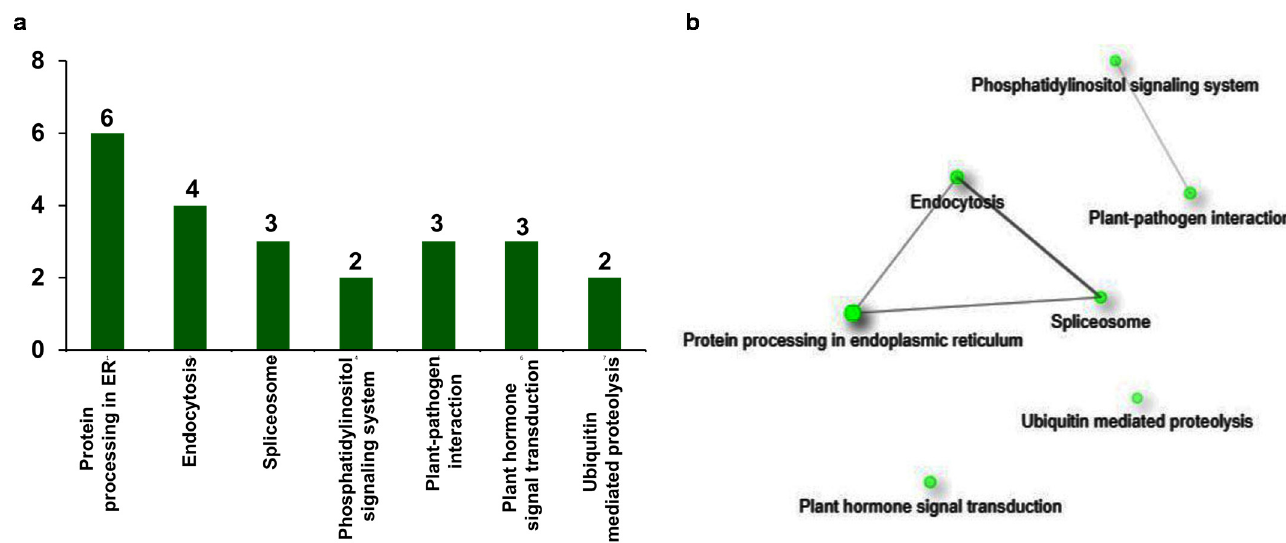
Figure 6. Distribution of stress-responsive genes across KEGG pathways. Among upregulated genes, stress-responsive genes were subjected to KEGG enrichment and network analysis. ( a ) KEGG enrichment analysis of 92 DEGs resulted in 23 annotated DEGs with at least one out of seven KEGG terms. ( b ) Network analysis of stress-responsive DEGs showed that the DEGs attributed to different defense-related pathways. Green nodes represent the functional groups. The size of the node is proportional to the number of genes, and darkness of the node is proportional to the enrichment value at FDR < 0.05. Grey lines (edges) that are joining the nodes are showing functional interrelations between the nodes.